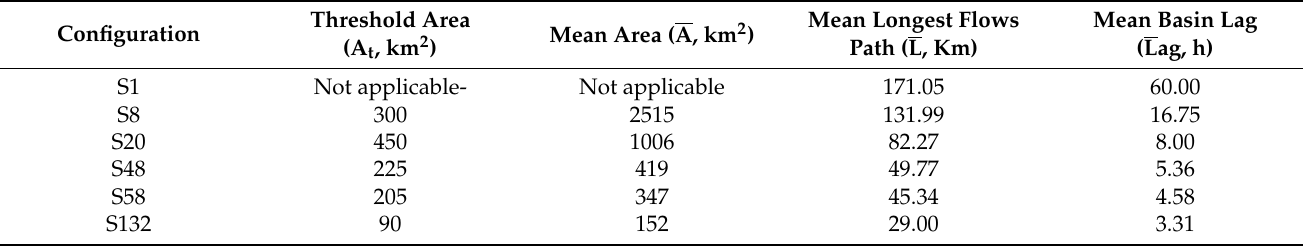
Table 5. Average values of topographical parameters of Sabari River Basin. The values for six configurations were calculated by taking the average value of all sub-basins of the corresponding configuration. Here, A t is the threshold area used to delineate the configuration, A is the mean area of the basin, L is the mean longest flow path, and Lag is the basin